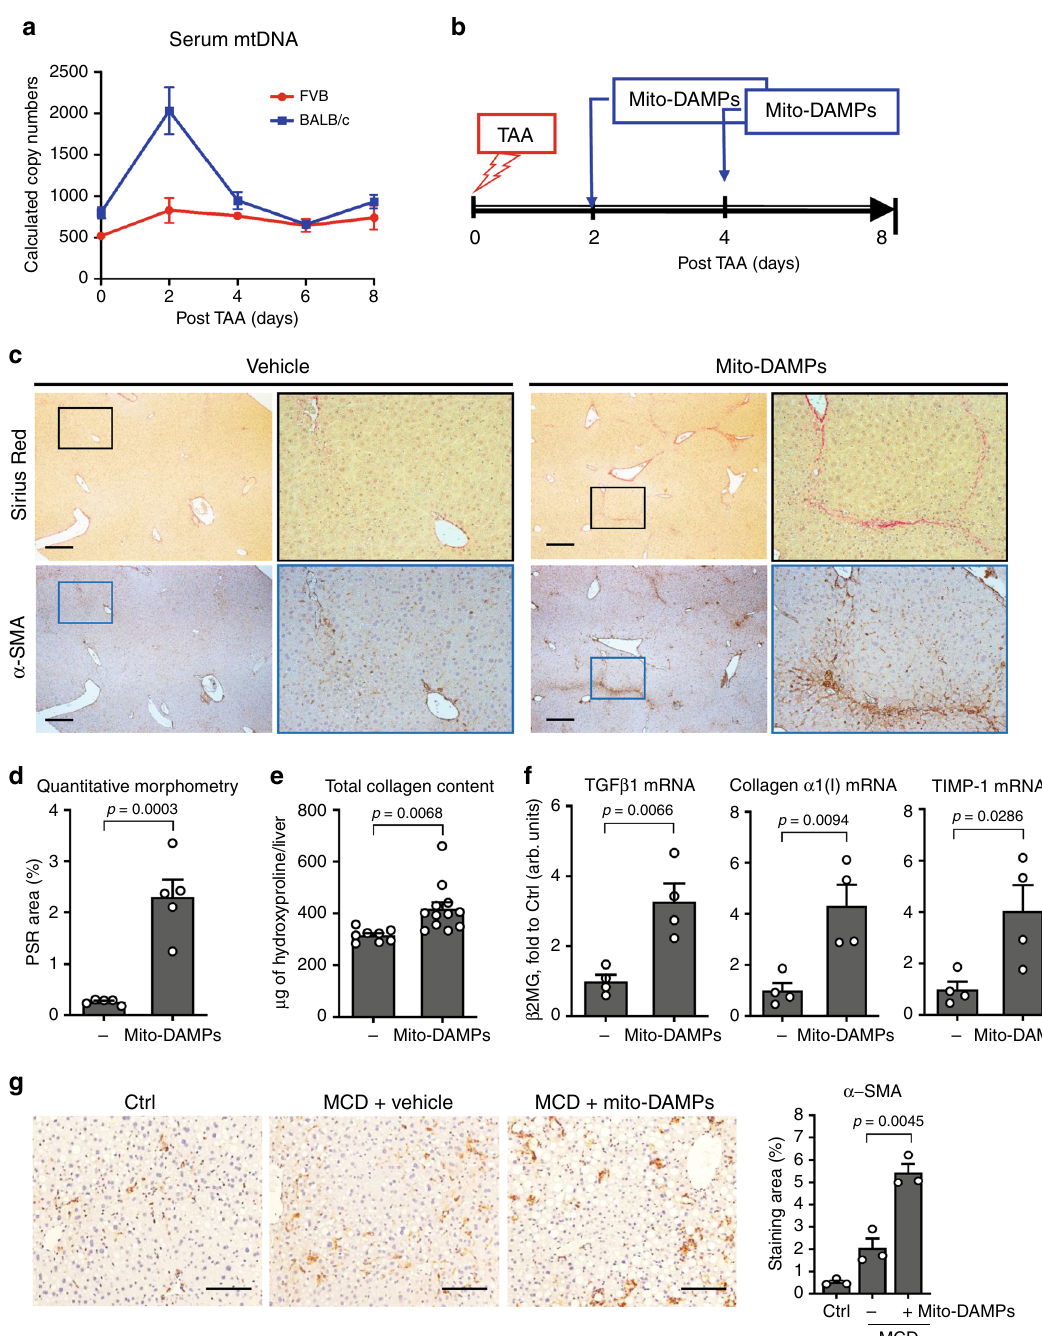
Fig. 5 Administration of hepatocyte-derived mito-DAMPs ampli fi es fi brogenic HSC activation in vivo and circumvent the resistance to fi brosis in FVB mice with TAA-induced liver injury. a Release of mito-DAMPs into systemic circulation is elevated in fi brosis-susceptible BALB/c, but not in resistant FVB strain 2 days after single TAA-induced liver injury, as quanti fi ed by mtDNA levels in the serum. Data shown are 12S mtDNA region QRT-PCR expressed as target copy number/ μ l of serum (means±SEM, for 0/2/4/6/8 days time-points, n = 6/5/4/9/4 (FVB), and n = 6/3/5/10/5 (BALB/c) of individual animals). b Scheme of exogenous hepatocyte mito-DAMP administration experiment. Puri fi ed mito-DAMPs (9.5 μ g of mtDNA/mouse) were injected intraperitoneally into FVB mice 2 and 4 days post-TAA injury, and fi brotic responses evaluated 8 days after TAA. c Connective tissue staining (Sirius Red, upper panel) and immunohistochemistry for α -SMA (lower panel) in livers of FVB mice with mito-DAMP injection. Representative images shown at low (×50; bar, 50 μ m) and high (×200) magni fi cation as indicated. d Quantitative morphometry of collagen area ( n = 5). e Hepatic collagen deposition is increased in mito-DAMP-treated FVB mice, as assessed biochemically via hydroxyproline content (controls ( − ), n = 8; mito-DAMPs, n = 12 individual animals). f Hepatic expression of pro- fi brogenic (pro-collagen α 1(I), TGF β 1, and TIMP-1) transcript levels as quanti fi ed by QRT-PCR ( n = 4). g Representative α -SMA staining images in C57Bl/6 mice with early-stage steatohepatitis due to MCD feeding for 2 weeks with morphometric quanti fi cation (×100, n = 3; bar, 50 μ m), 24h after mito-DAMP administration (9.5 μ g of mtDNA/mouse, i.p.). Results are expressed as means± SEM, and in arbitrary units (fold to healthy controls) relative to β 2MG mRNA as described in “ Methods. ” Two-tailed p value indicated as compared to vehicle controls (unpaired t test). Source data are provided as a Source Data fi